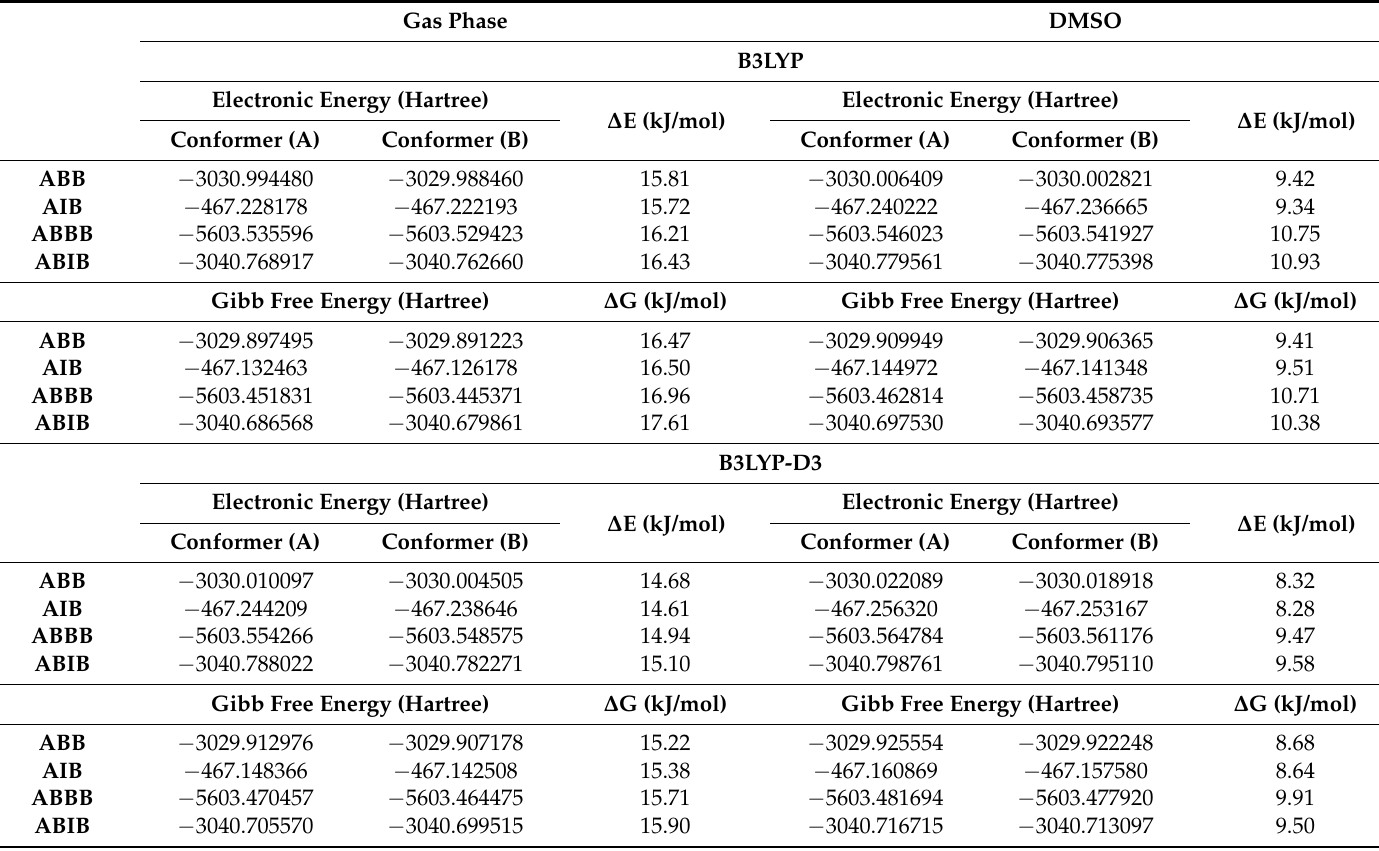
Table 1. Electronic energy of the conformers of the four studied compounds and their energy difference in the gas phase and in